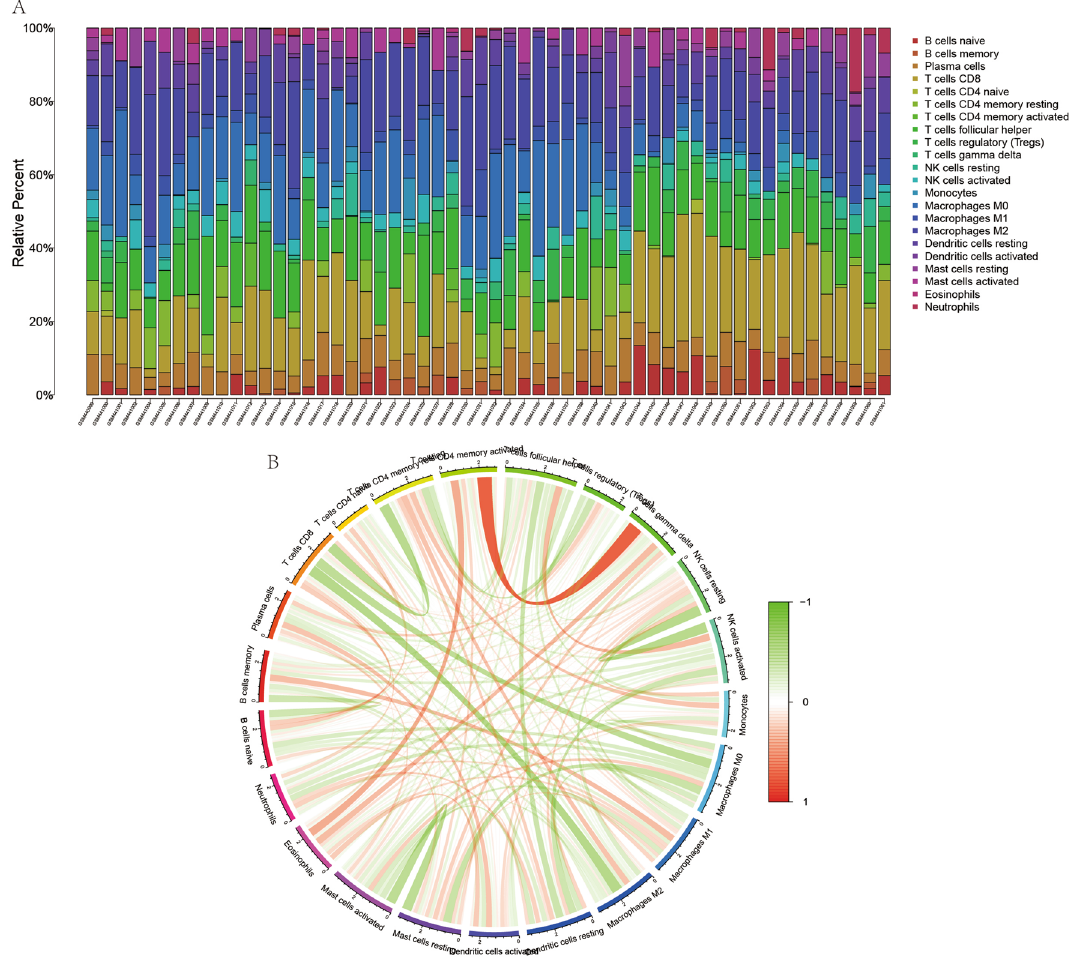
Figure 8. Immune cell composition and correlation analysis. ( A ) represents the analysis of immune cell composition for all cases, with each color indicating one immune cell. ( B ) represents the correlation analysis between immune cells, with red connecting lines indicating synergistic high expression and green links indicating synergistic low